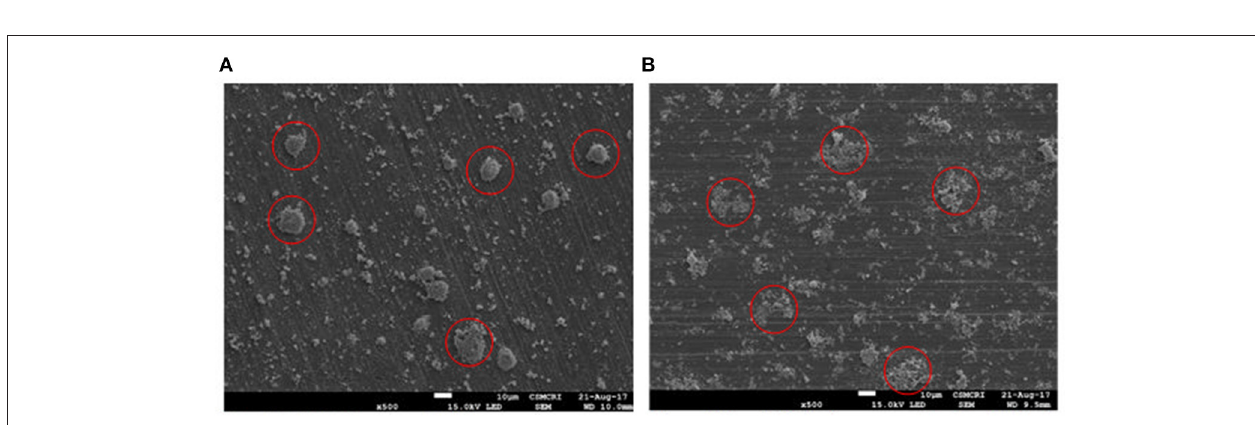
surface area comes from the existence of HRO in the